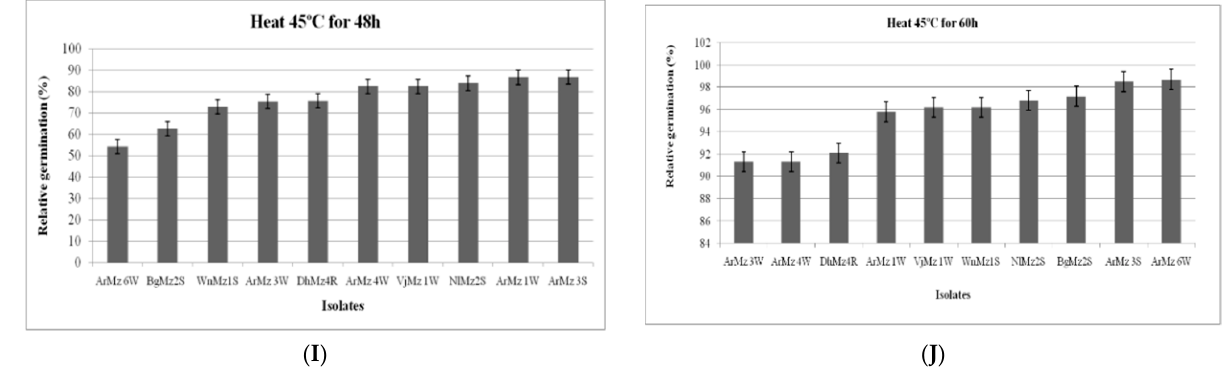
Figure 6. Relative germination of different isolates of Metarhizium sp., exposed at 45 °C. Relative germination (RG) of Metarhizium spp. conidia exposed for ( A ) 2 h, ( B ) 4 h, ( C ) 6 h, ( D ) 8 h, ( E ) 10 h, ( F ) 12 h, ( G ) 24 h, ( H ) 36 h, ( I ) 48 h, and( J ) 60 h. RG was calculated in relation to non-heated controls.